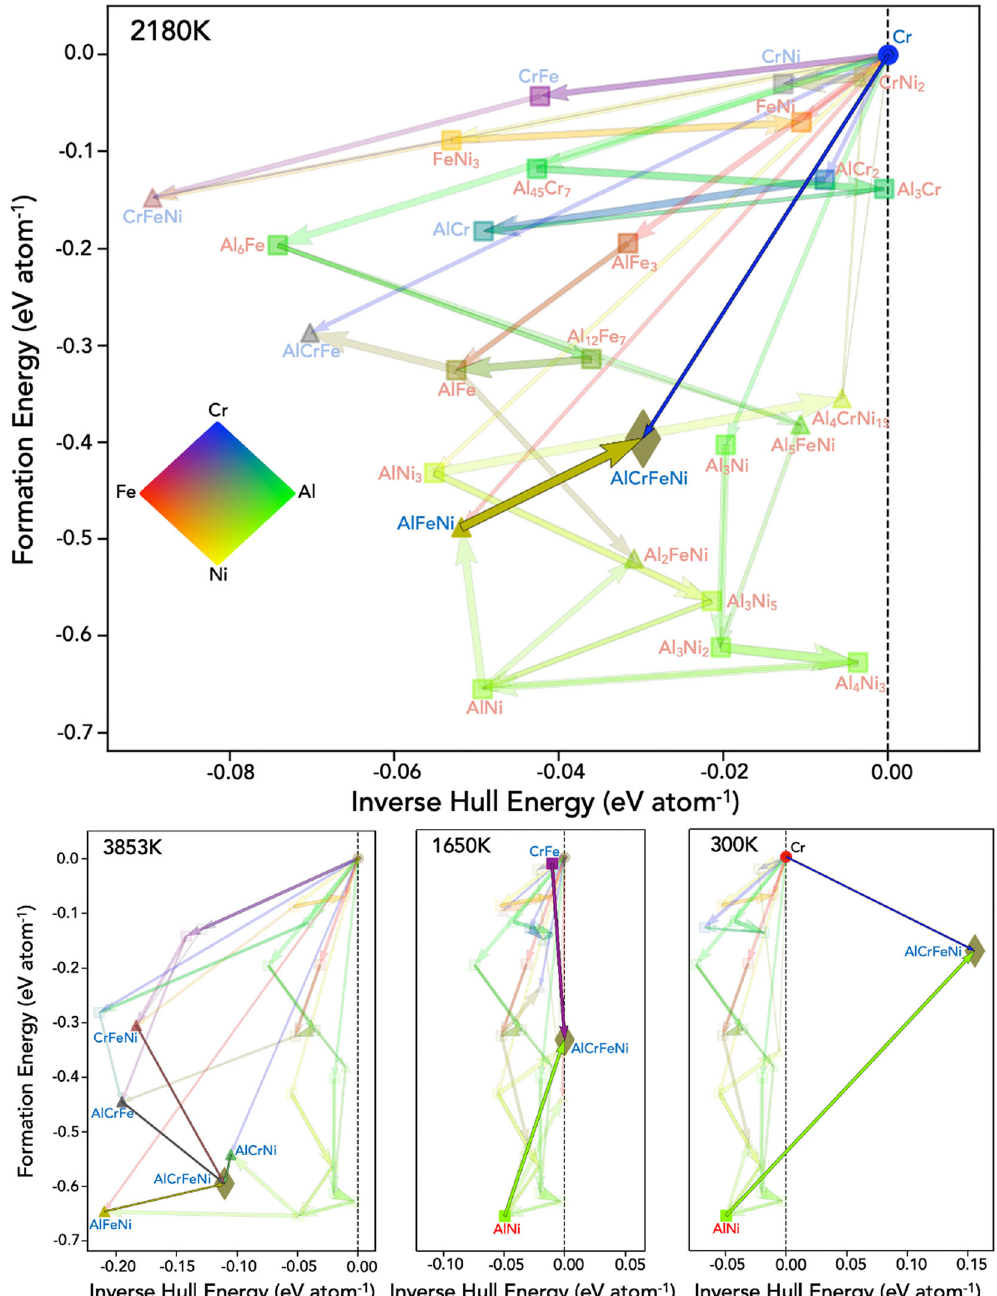
Fig. 5 Inverse hull web of AlCrFeNi. AlCrFeNi system at temperatures of 2180, 3853, 1650, and 300 K. The top Inverse Hull Web is at 2180 K, the highest melting temperature in the Al − Cr − Fe − Ni system, and the bottom left Inverse Hull Web is at 3853 K, AlCrFeNi ’ s ‘ critical adjacent phase ’ temperature. The bottom left Inverse Hull Web is at 1650 K, AlCrFeNi ’ s ‘ critical solid-solution ’ temperature, and the bottom right Inverse Hull Web is at room temperature. A video of this Inverse Hull Web at decreasing temperatures from 2500 to 300 K can be found in Supplementary Video